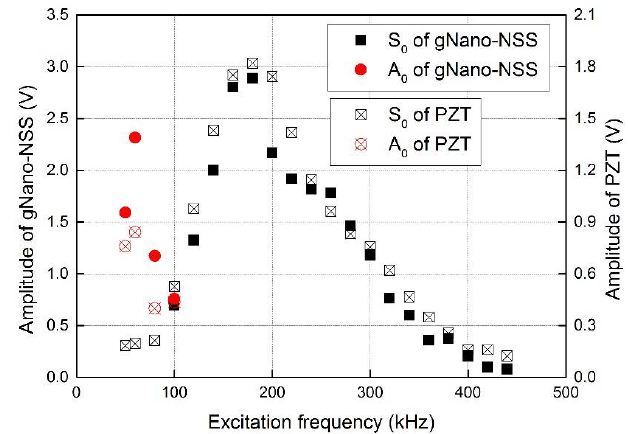
Figure 13. Comparison of time-frequency-amplitude response signals of UGW propagation in laminates captured by the gNano-NSS and by PZT sensors at point I.